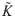
Unsuccessful implementations of Besag’s edge correction term at non-binary fields of view (K˜ with respect to event density at different radii).The normalized and centered K-function (K˜), as described by Lagache et al, was calculated at different particle intensities and radii using simulated square fields of view measuring 256 x 256 pixels, with a homogeneous Poisson distribution of particles (Complete Spatial Randomness). Densities are expressed in particles per pixel. The black line represents the mean K˜ and the dotted lines represent the upper and lower critical quantiles (Q01 and Q99). Each mean/quantile was determined using a set of 1000 simulations. Panel A: Applying Besag’s correction term only to edge pixels, by dividing the pixels within a given radius by the area of an ideal circle of the same radius. It can be seen that K˜ is no longer centered around zero at high particle intensities. Panel B: Same as panel A, but dividing by a pixelated circle rather than an ideal one. Like panel A, it can be seen that K˜ is no longer centered around zero at high intensities. Panel C: For comparison, K˜ was calculated without applying any edge correction terms. It can be seen that edge effects play a significant role at high particle intensities, making K˜ deviate remarkably from zero.